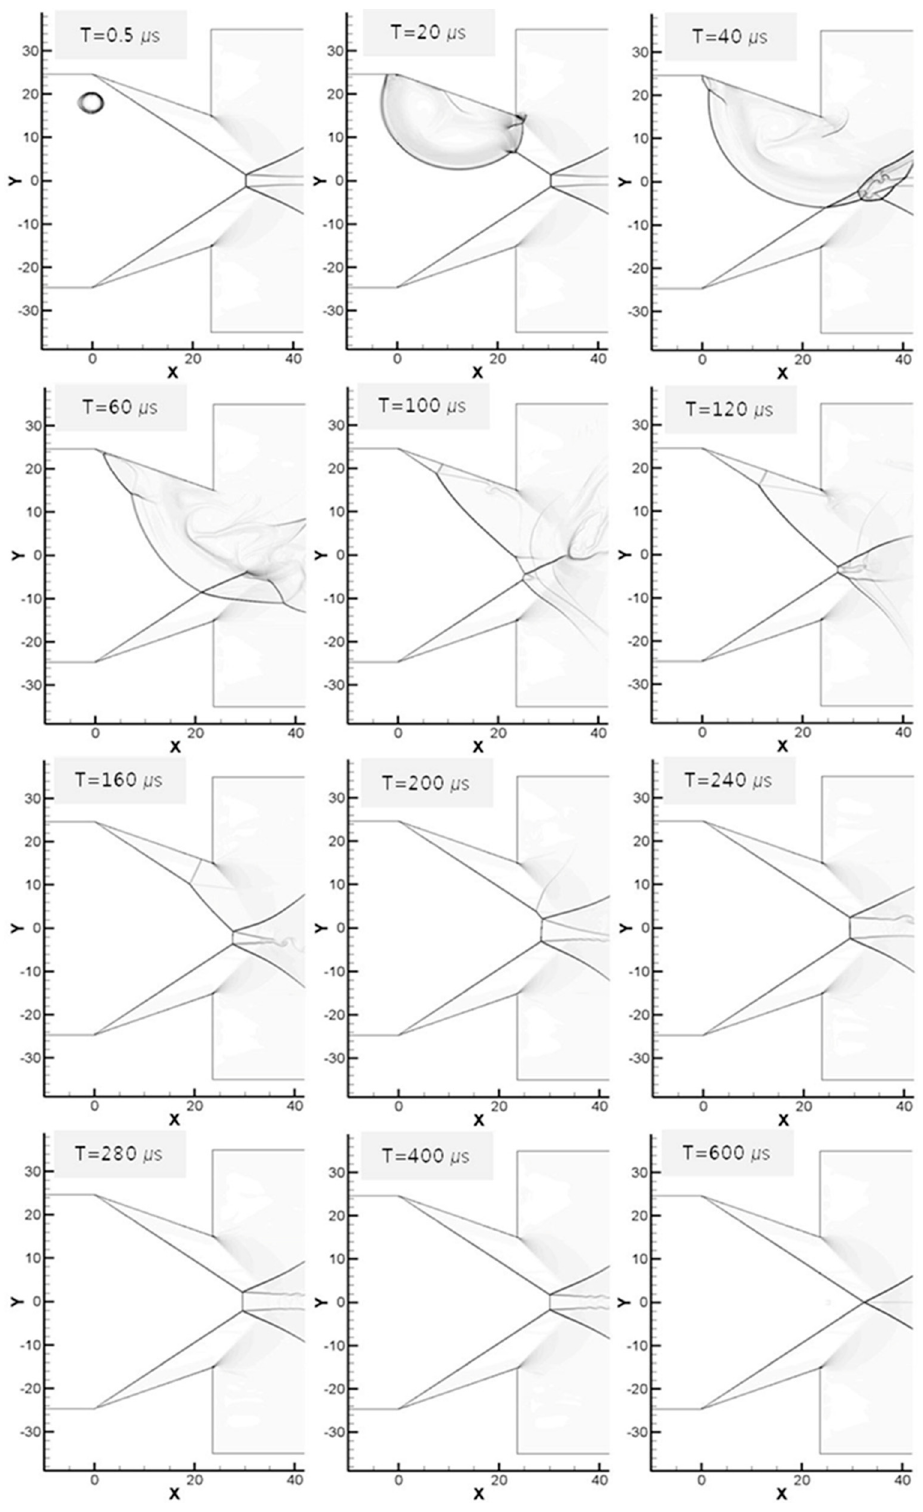
Figure 9. Interaction between blast wave and oblique shock, deposition upstream of the wedges. Energy: 107.5 mJ.